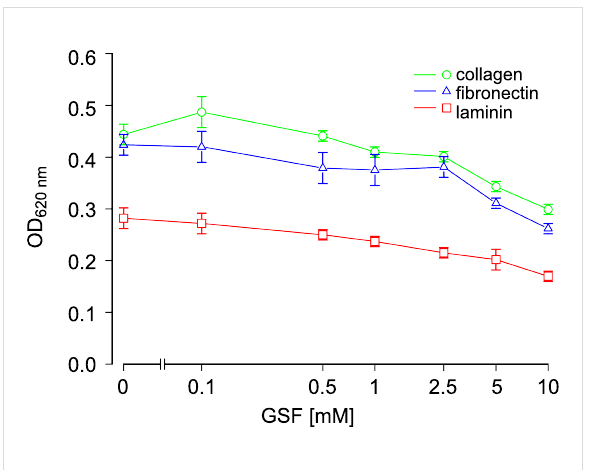
Figure 7: Adhesion of HBMEC-60 to extracellular matrix proteins. Prior to the adhesion experiments, HBMEC-60 cells were incubated for 30 min with (4-{[( β -D-galactopyranosyl)oxy]methyl}furan-3-yl)methyl hydrogen sulfate (GSF) at the concentrations indicated. The cells were then seeded onto plates coated with fibronectin, collagen or laminin. After 30 min nonadherent cells were removed, and adherent cells were fixed, stained with methylene blue, and washed; the cell-bound dye was then extracted and the absorption determined photometrically. In some experiments cells were also stimulated with TNF as described in the Experimental section. TNF pretreatment of cells resulted in virtu- ally the same adhesive properties as without TNF and with a signifi- cant inhibition of adhesion by GSF at 5 mM. The values shown are the mean and SD of six replicates. The same results were obtained in two independent